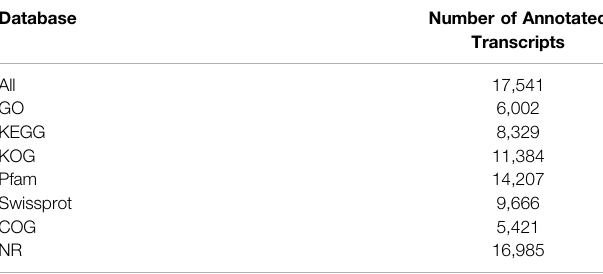
TABLE 2 | Annotated transcript number statistics table.